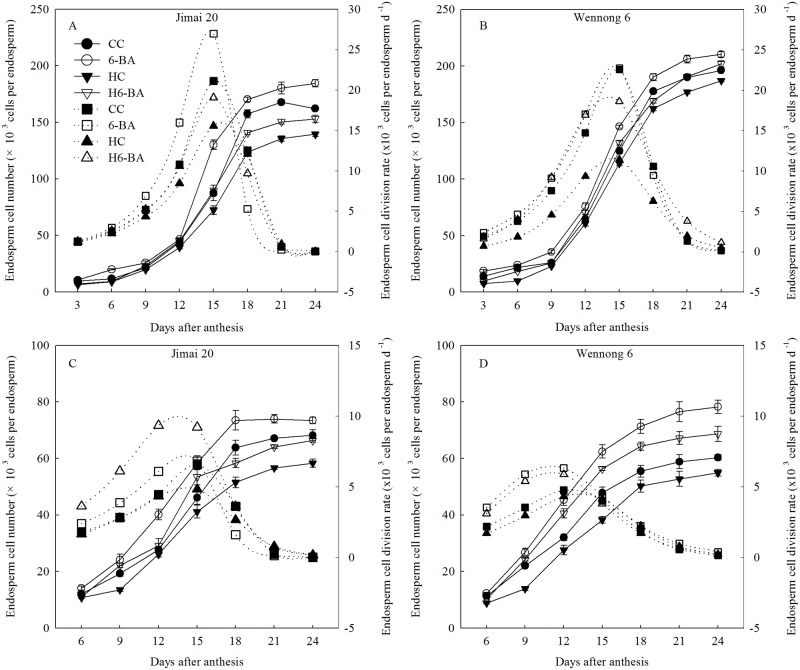
Endosperm cell number and endosperm cell division rate for superior (A, B) and inferior kernels (C, D).CC and 6-BA represent treatment with water and 6-BA under non-heated condition, respectively. HC and H6-BA represent treatment with water and 6-BA under heated condition, respectively. Solid line and dotted line represent endosperm cell number and endosperm cell division rate, respectively. Vertical bars represent ± standard error of the mean (n = 9) where they exceed the size of the symbol.